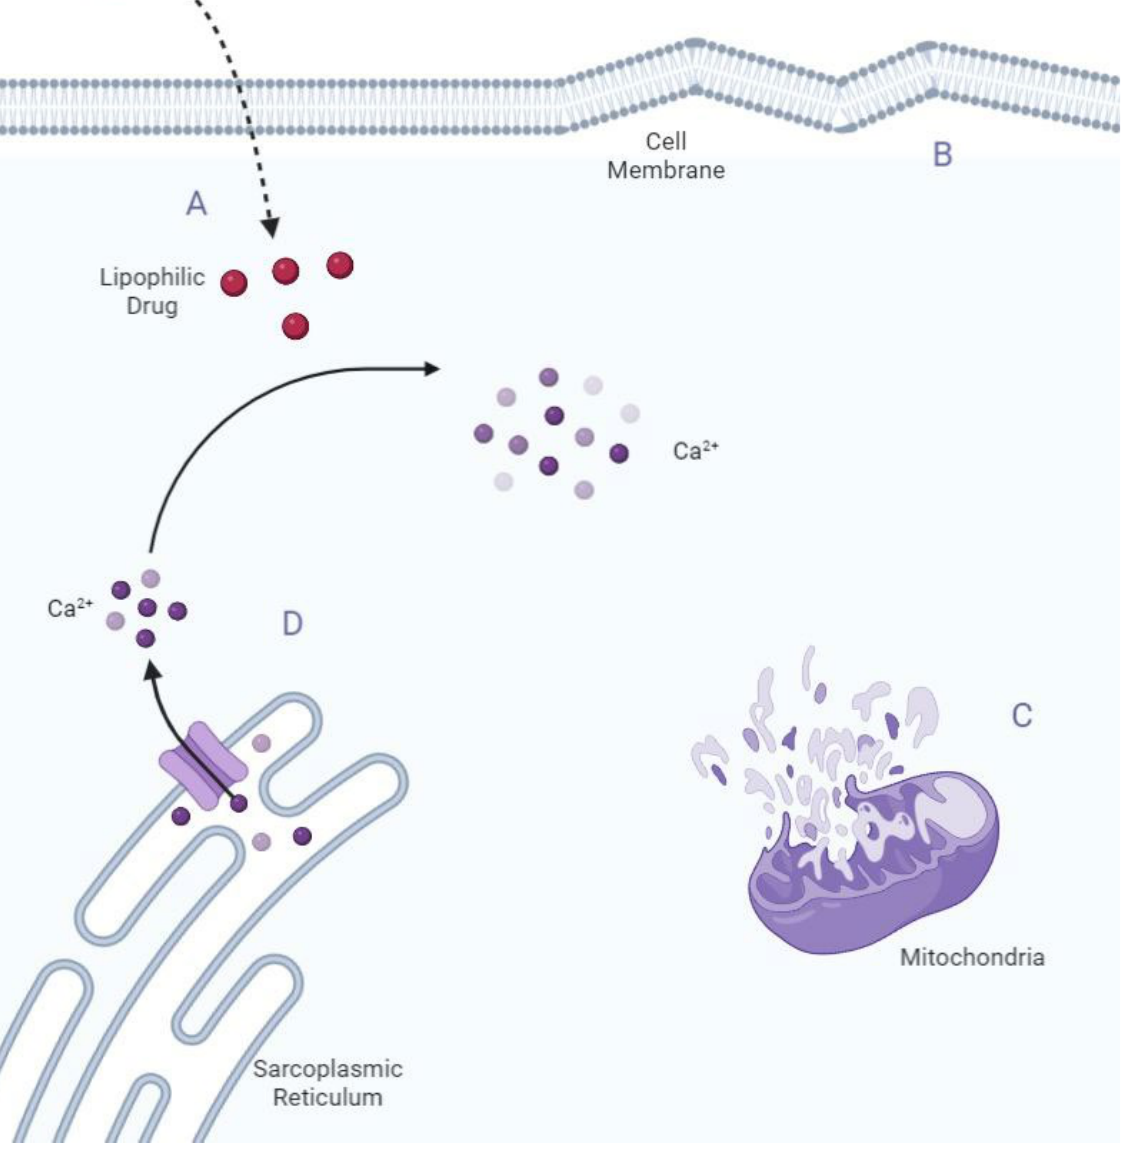
Figure 1. Mechanisms of negative effects of caspofungin on cardiomyocytes. ( A ) Caspofungin lipophilicity can lead to a high concentration in cardiomyocytes; ( B ) Cell member lysis; ( C ) Mitochon- drial toxicity; ( D ) Ryanodine receptor activation and increased intracellular calcium release from the sarcoplasmic reticulum.